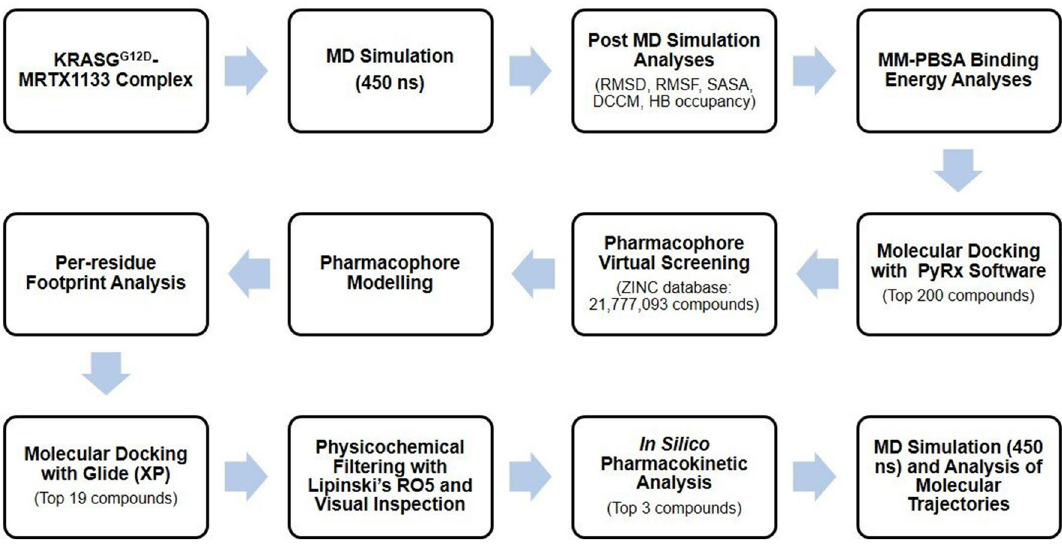
Figure 1. Schematic diagram of the approach applied to this study. First four sections indicate the characterization approach applied to MRTX1133, while rest of the sections depict the process of hit compounds